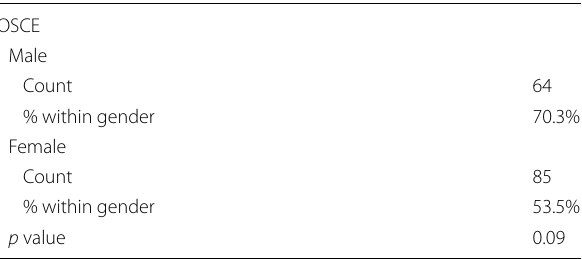
Table 5 Gender differences in the value of OSCE as